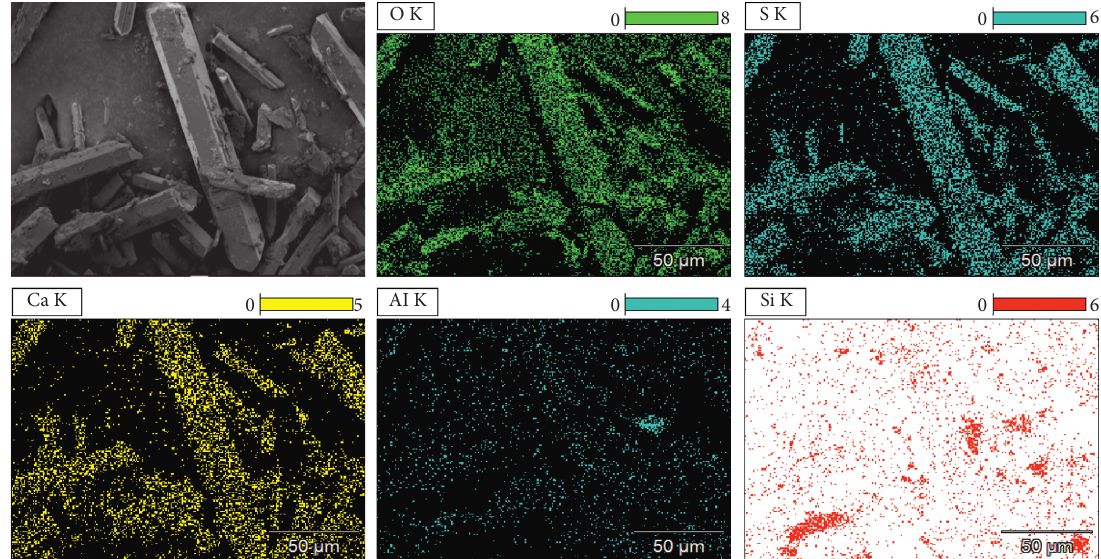
Figure 7: SEM and EDS spectroscopy at 100 ° C for 1h with 5 mM Al 3+